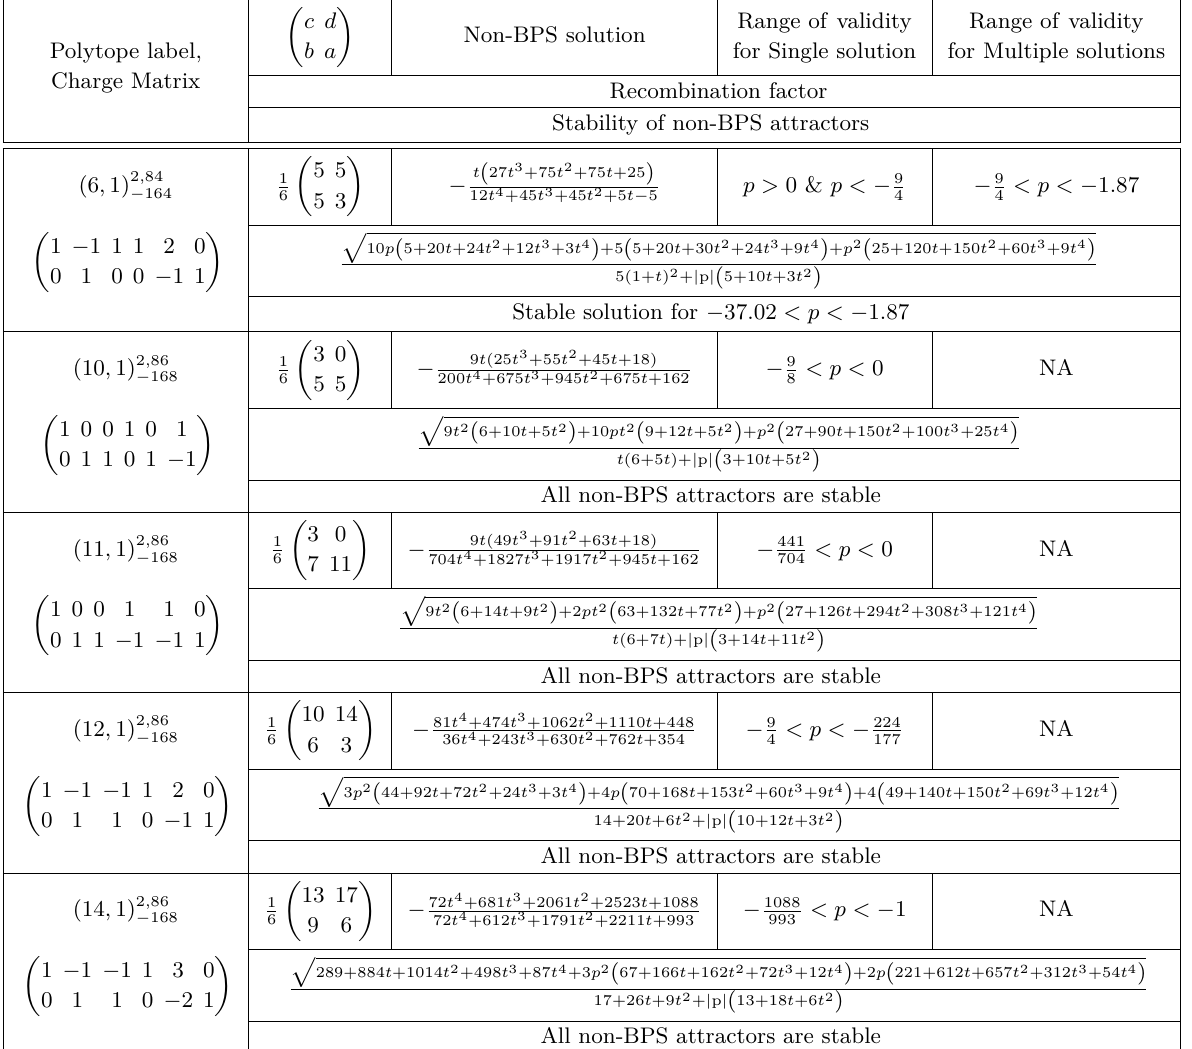
already discussed here; they are related to each other by a flop (for more detail, see e.g.